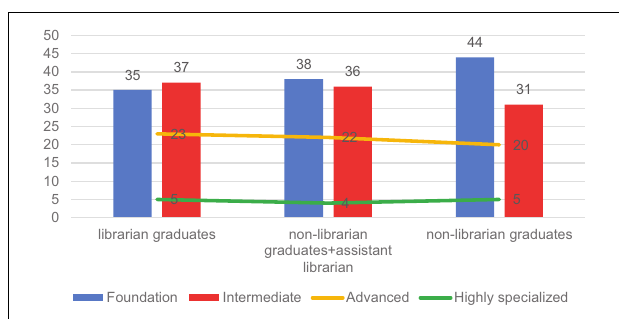
FIGURE 7 | Safety. Diplomas and qualifications.